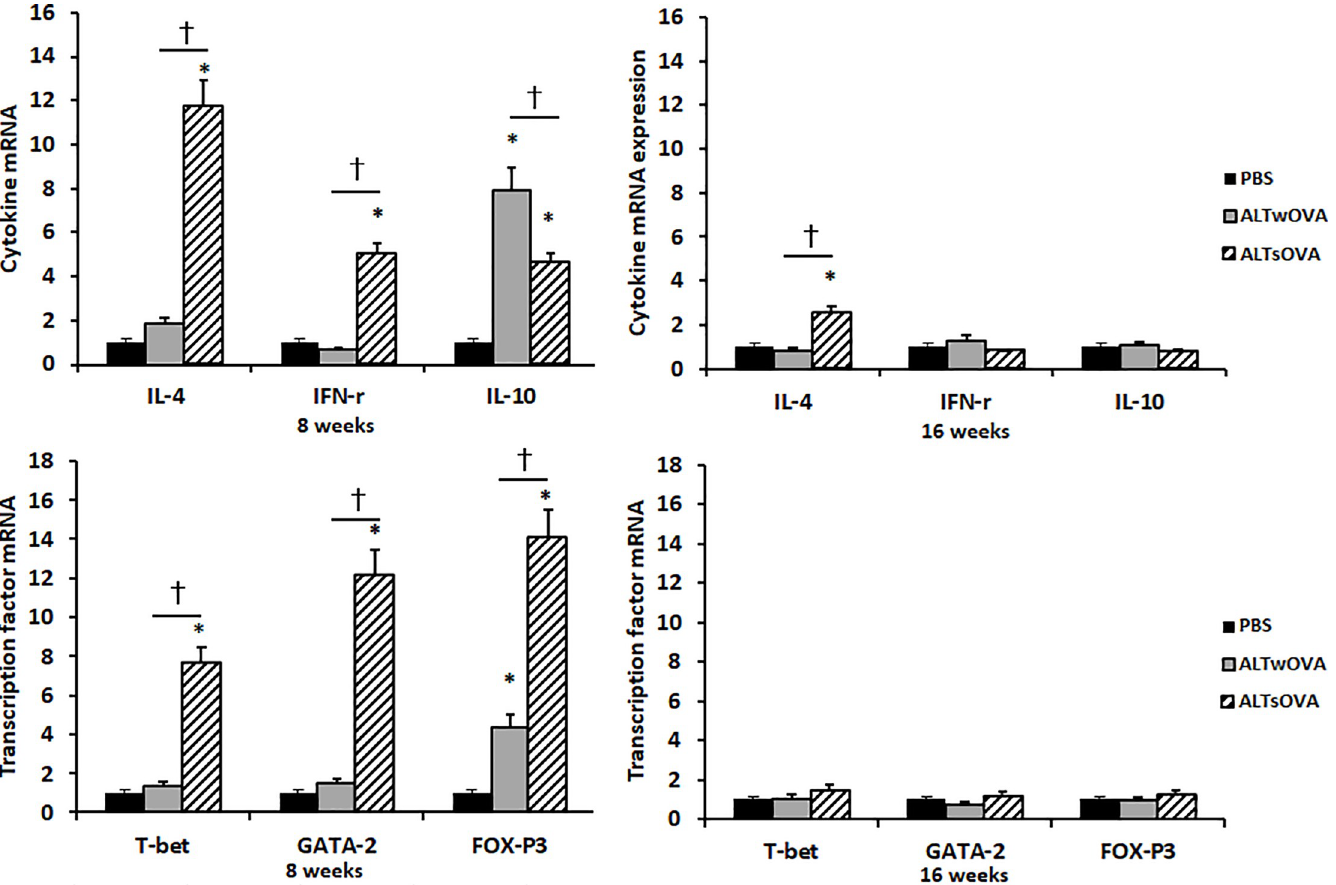
Fig 5. Chemical mediator mRNA and transcription factor expression in sinonasal mucosa of Alternaria induced Chronic RhinoSinusitis (CRS) mouse model. IL- 4 and IFN- γ and their transcription factor mRNA expression were significantly increased non-allergic CRS group at 8 weeks. IL-10 and its transcription factor mRNA expression were significantly increased both allergic and non-allergic CRS group at 8 weeks (3–4 mice per group). NC: negative control, ALTwOVA: Alternaria instillation with ovalbumin (OVA) presensitization, ALTsOVA; Alternaria instillation without ovalbumin (OVA) presensitization. � p < 0.05 vs NC group, †p < 0.05 vs with or without OVA